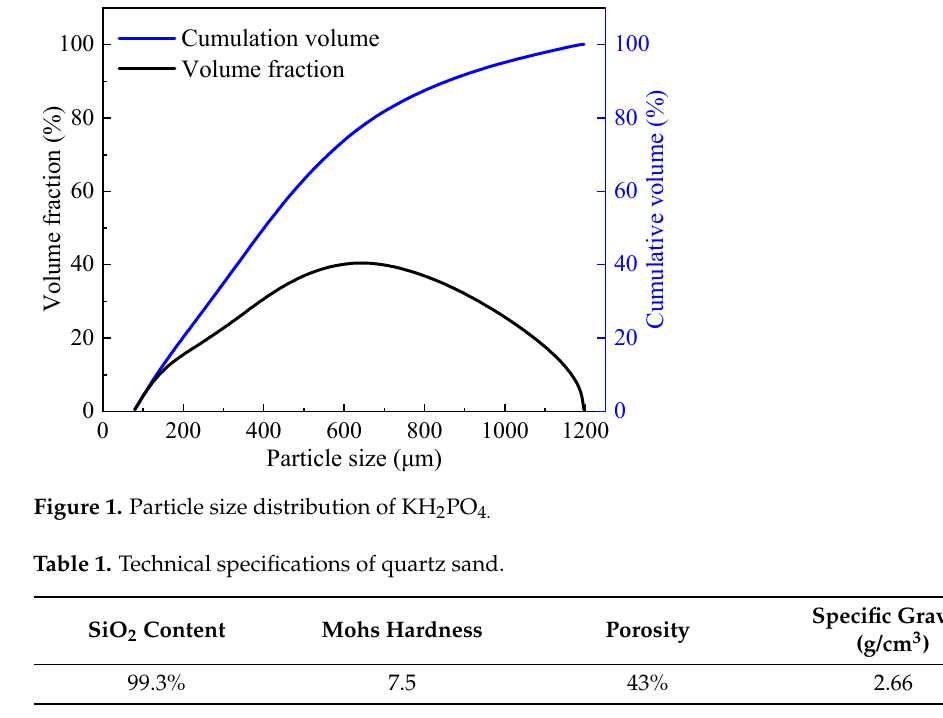
Table 2. Technical specifications of fly ash.